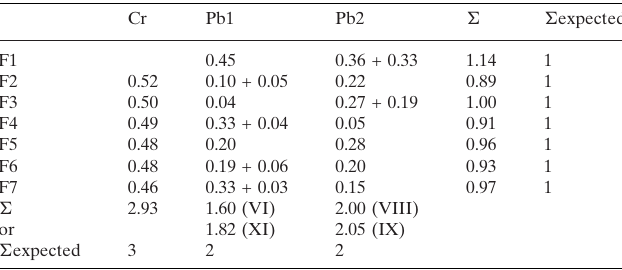
Valence-bond analysis according to the empirical expression from Brown & Altermatt (1985), using parameters for solids from Brese & O’Keeffe (1991), with two results for Pb1 and Pb2 according to their coordinations (respectively VI or XI, and VIII or IX). Cr Pb1